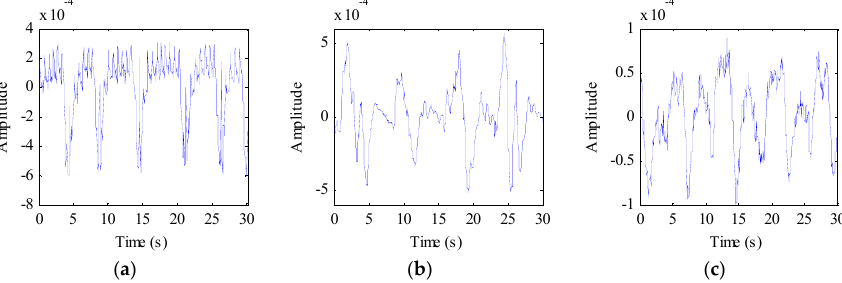
Figure 7. Received radar echoes after background removal. ( a ) Target is 1 m away from the radar; ( b ) Target is 2 m away from the radar; ( c ) Target is 3 m away from the radar.